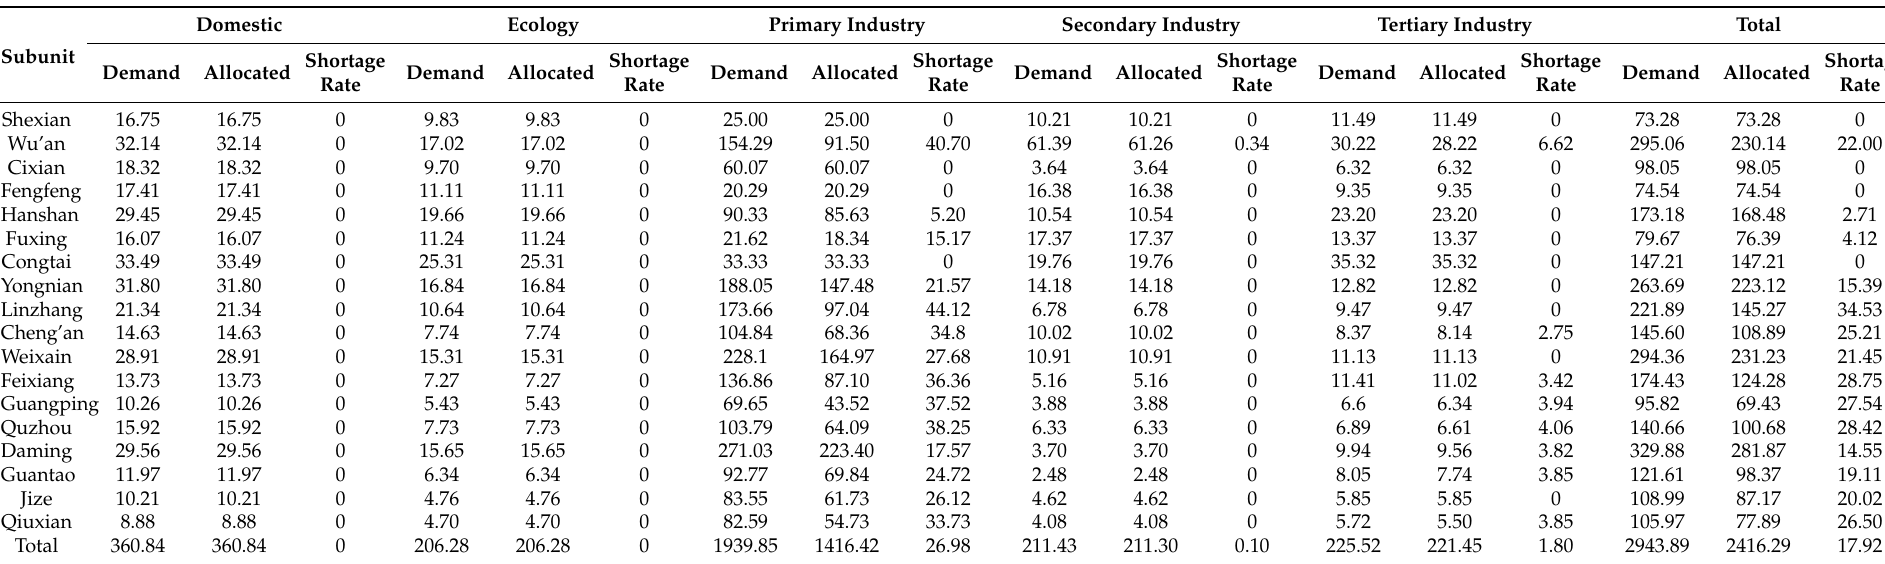
Table 4. Optimal allocation results and water shortage rate for water resources in different industries in Handan in 2025 (10 6 m 3 ,